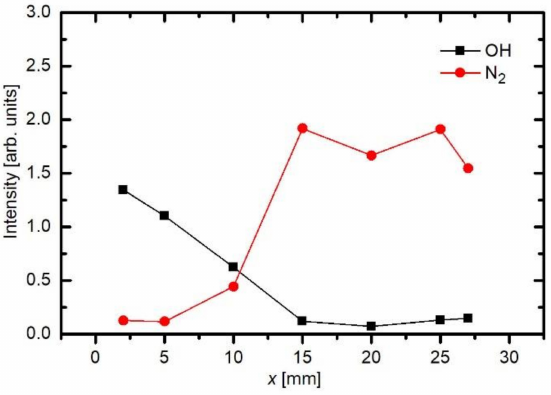
Figure 6. The intensities of nitrogen (337 nm) and OH normalized to the main Ar line at 764